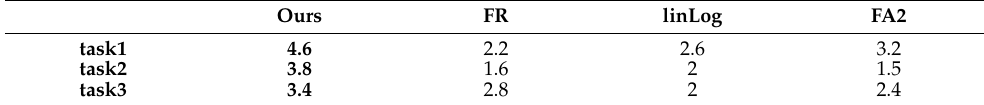
Table 6. Average scores of users